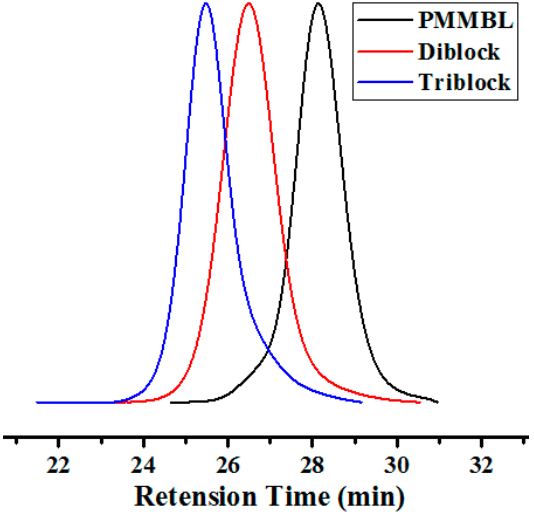
Figure 9. GPC traces of homopolymer PMMBL (black), diblock copolymer PMMBL- b -PMBL (red), and triblock copolymer PMMBL- b -PMBL- b -PMMBL (blue) produced by i Bu SKA/B(C 6 F 5 ) 3 in CH 2 Cl 2 at RT.